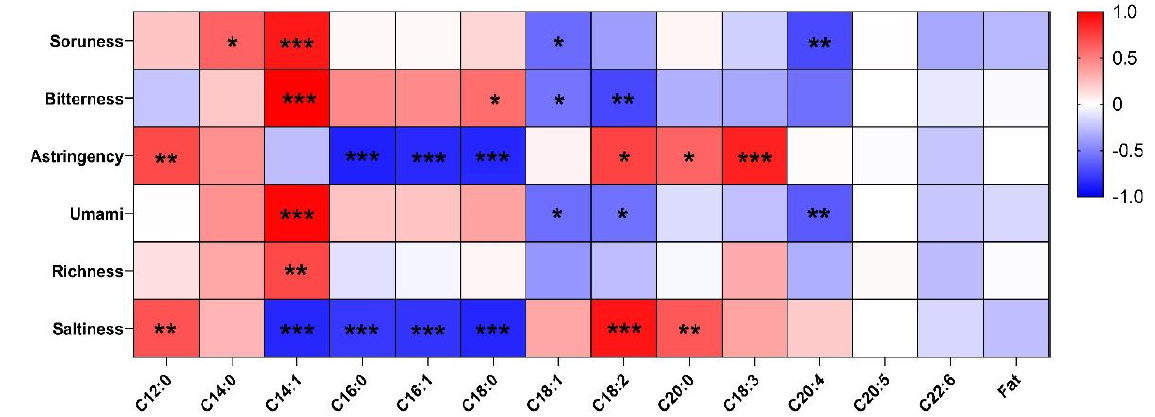
Figure 4. The correlation coefficient between the fatty acid profile and the electronic tongue system. * p < 0.05, ** p < 0.01, *** p < 0.001.